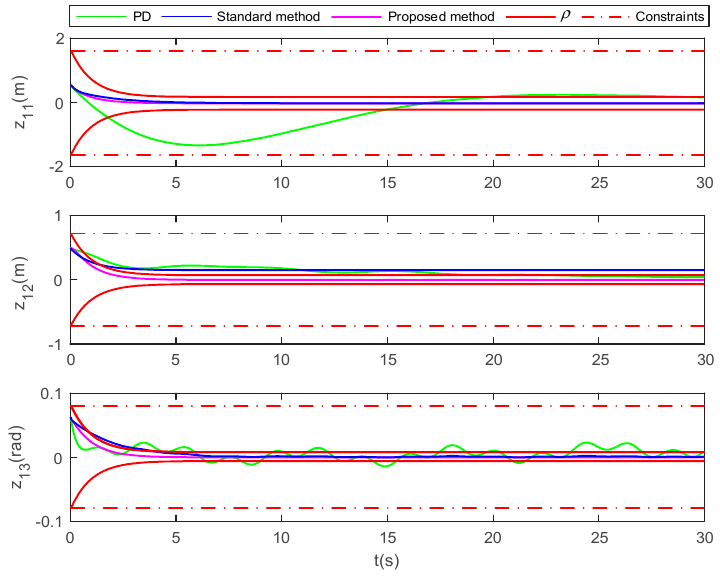
Figure 5. Pose tracking error of the vessel under three control methods.